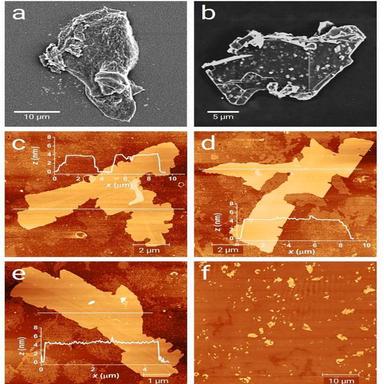
(a)-(b) SEM and (c)-(e) AFM images of representative single MoS2 flakes. (f) AFM image of a large area of the MoS2 sample.